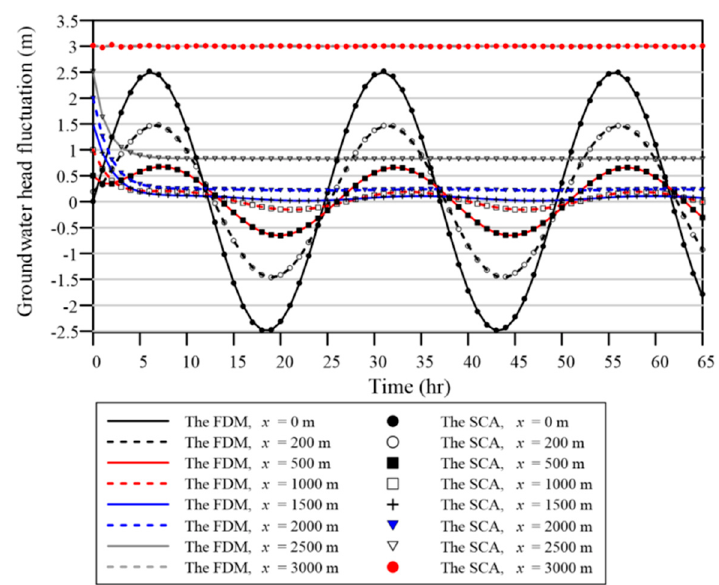
Figure 10. Result comparison of example 3 (case B).